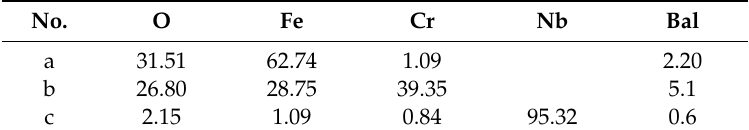
Figure 6. Cross-sectional morphologies of the three groups of alloys after oxidation in pure water vapor